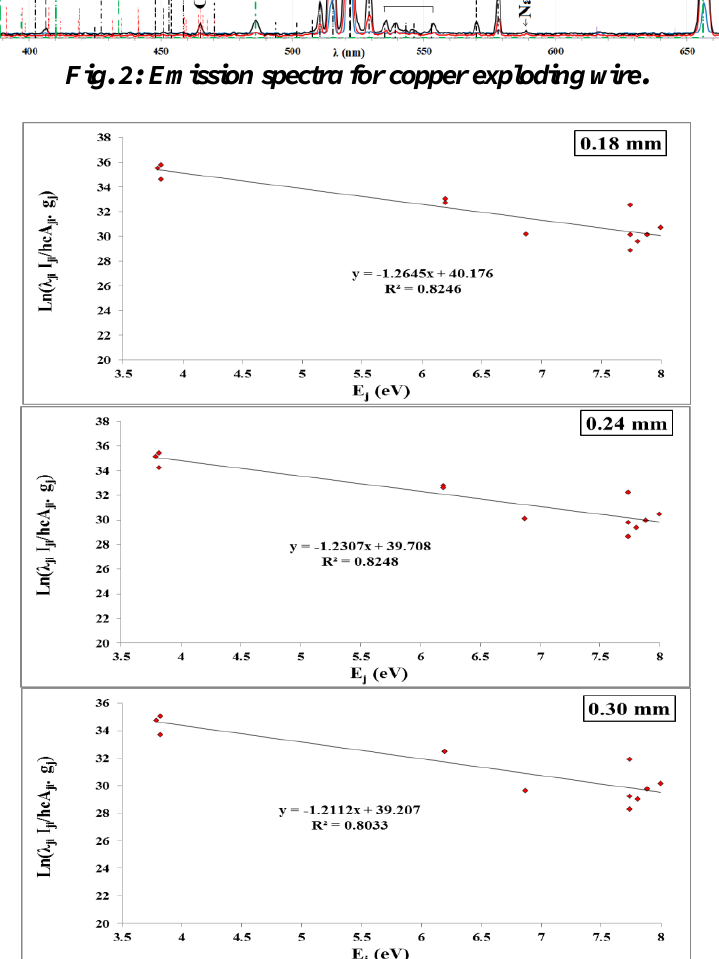
Fig. 2: Emission spectra for copper exploding wire.